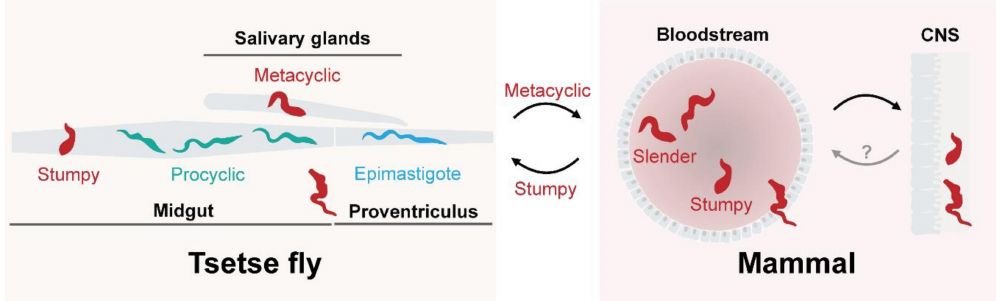
Figure 1. Simplified life cycle of Trypanosoma brucei . Parasites in the stumpy stage differentiate into procyclic forms inside the midgut of the tsetse fly. Procyclic forms of the parasite express a procyclin surface that changes throughout the infection of the midgut. On route to the salivary glands, trypanosomes cross the proventriculus, differentiate into epimastigotes, and switch the procyclin coat to bloodstream stage alanine-rich protein BARP. The final stage of infection in the tsetse fly takes places in the salivary glands; the parasites differentiate into metacyclic forms and express variant surface glycoproteins (VSGs), ready to infect a new host. Through a blood meal, trypanosomes reach the bloodstream of a mammalian host and differentiate into the replicative, long and slender form. This may also involve the skin, lymphatics and adipose tissues, but which are omitted for simplicity. As the levels of parasitemia increase, trypanosomes differentiate into the infective, non-replicative short and stumpy form. Trypanosomes are also able to reach the cerebrospinal fluid and to cross the blood brain barrier into the central nervous system (CNS). It is unclear if this population is in equilibrium with the bloodstream stages. The dominant proteins in each stage of the infection are indicated by colour: VSG; red, BARP; blue and procyclin;